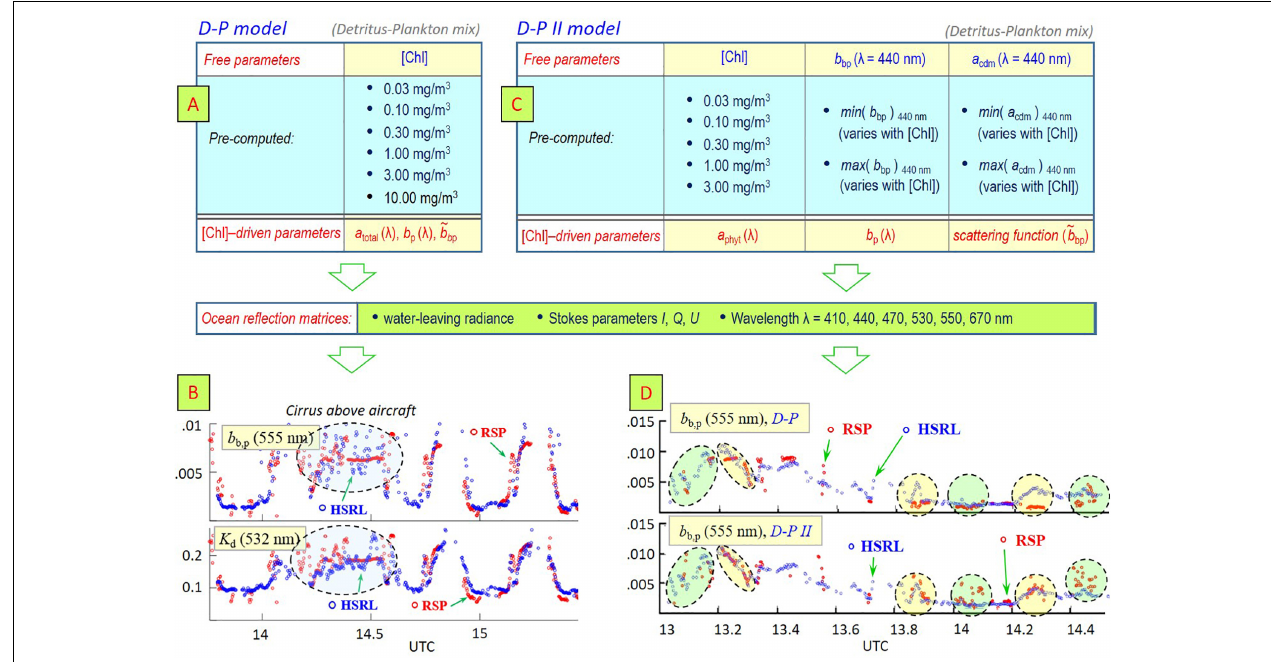
FIGURE 5 | (A) D-P model parameters used for RSP analyses. (B) Comparison for the SABOR campaign between b b , p and K d values that were retrieved from analyses of HSRL data and from analyses of RSP data using the D-P model. The scatter in the blue-shaded area coincides with the occurrence of cirrus clouds above the aircraft. (C) D-P II model parameters used for RSP analyses. (D) Comparison for the NAAMES campaign between b b , p values that were retrieved from analyses of HSRL data and from analyses of RSP data using the D-P model (upper diagram) and the D-P II model (lower diagram). Yellow and green shaded areas correspond to regions of better and worse agreement when using the D-P II